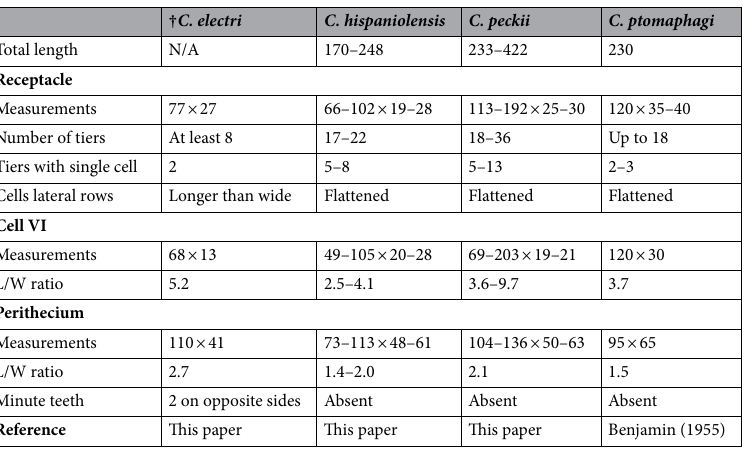
Table 1. Comparative table of descriptive characteristics for currently described species of Columnomyces . All measurements are in